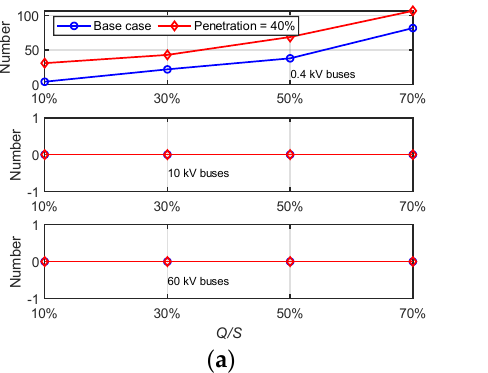
Figure 11. The worst overvoltage situations of buses at different Q setpoints (with constant Q ): ( a ) Yearly maximum number of overvoltage buses; ( b ) Yearly maximum bus voltage.